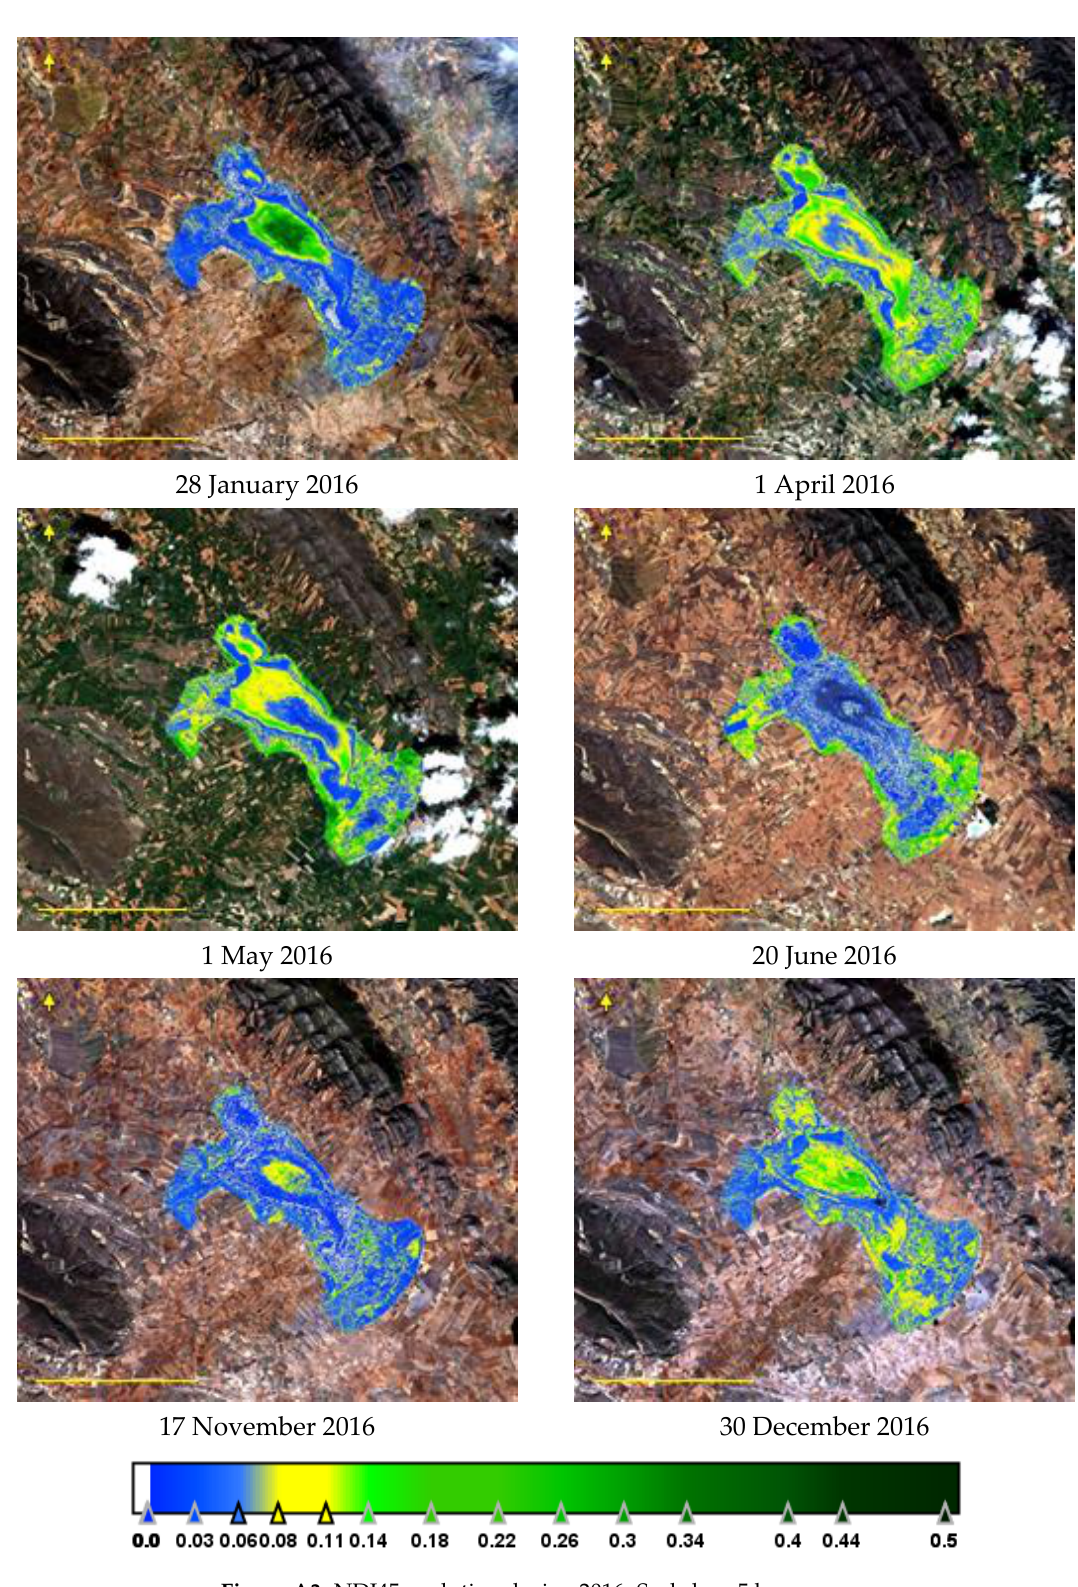
Figure A3. NDI45 evolution during 2016. Scale bar: 5 km.